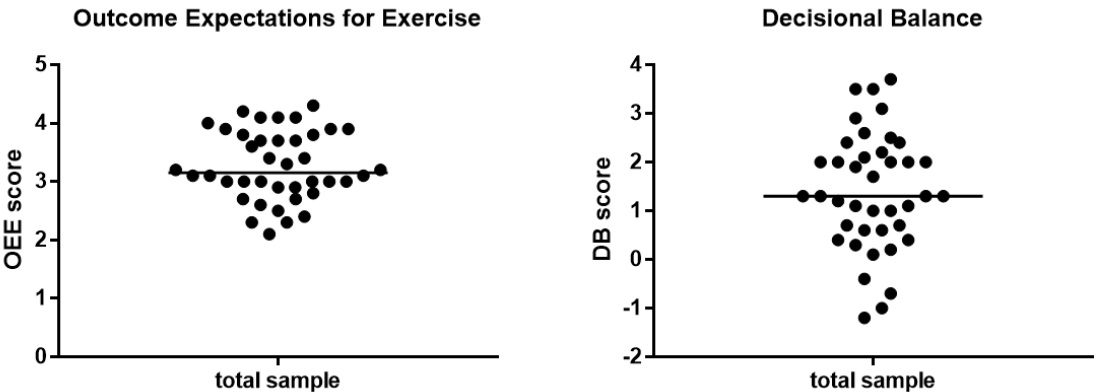
Figure 2. Baseline scores for OEE and DB scale divided by median. OEE: Interquartile range = 0.9; min-max = 2 − 4.3. DB: Interquartile range = 1.6; min-max = − 1.2 − 3.5. Abbreviations: OEE, outcome expectations for exercise; DB, decisional